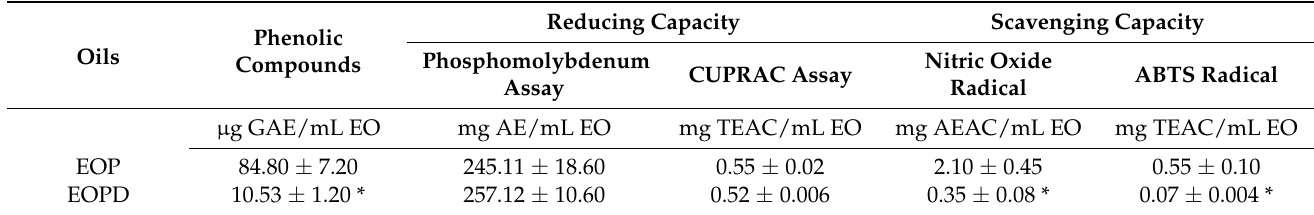
Figure 2. GC chromatogram of the sesquiterpene fractions of orange essential oil obtained using the cold-pressed method (EOP). Table 1. Chemical constituents of essential oils obtained from fruit peels of Citrus sinensis (L.) Osbeck (Rutaceae). Table 2. Antioxidant activity of Citrus sinensis oils by total phenolic composition.